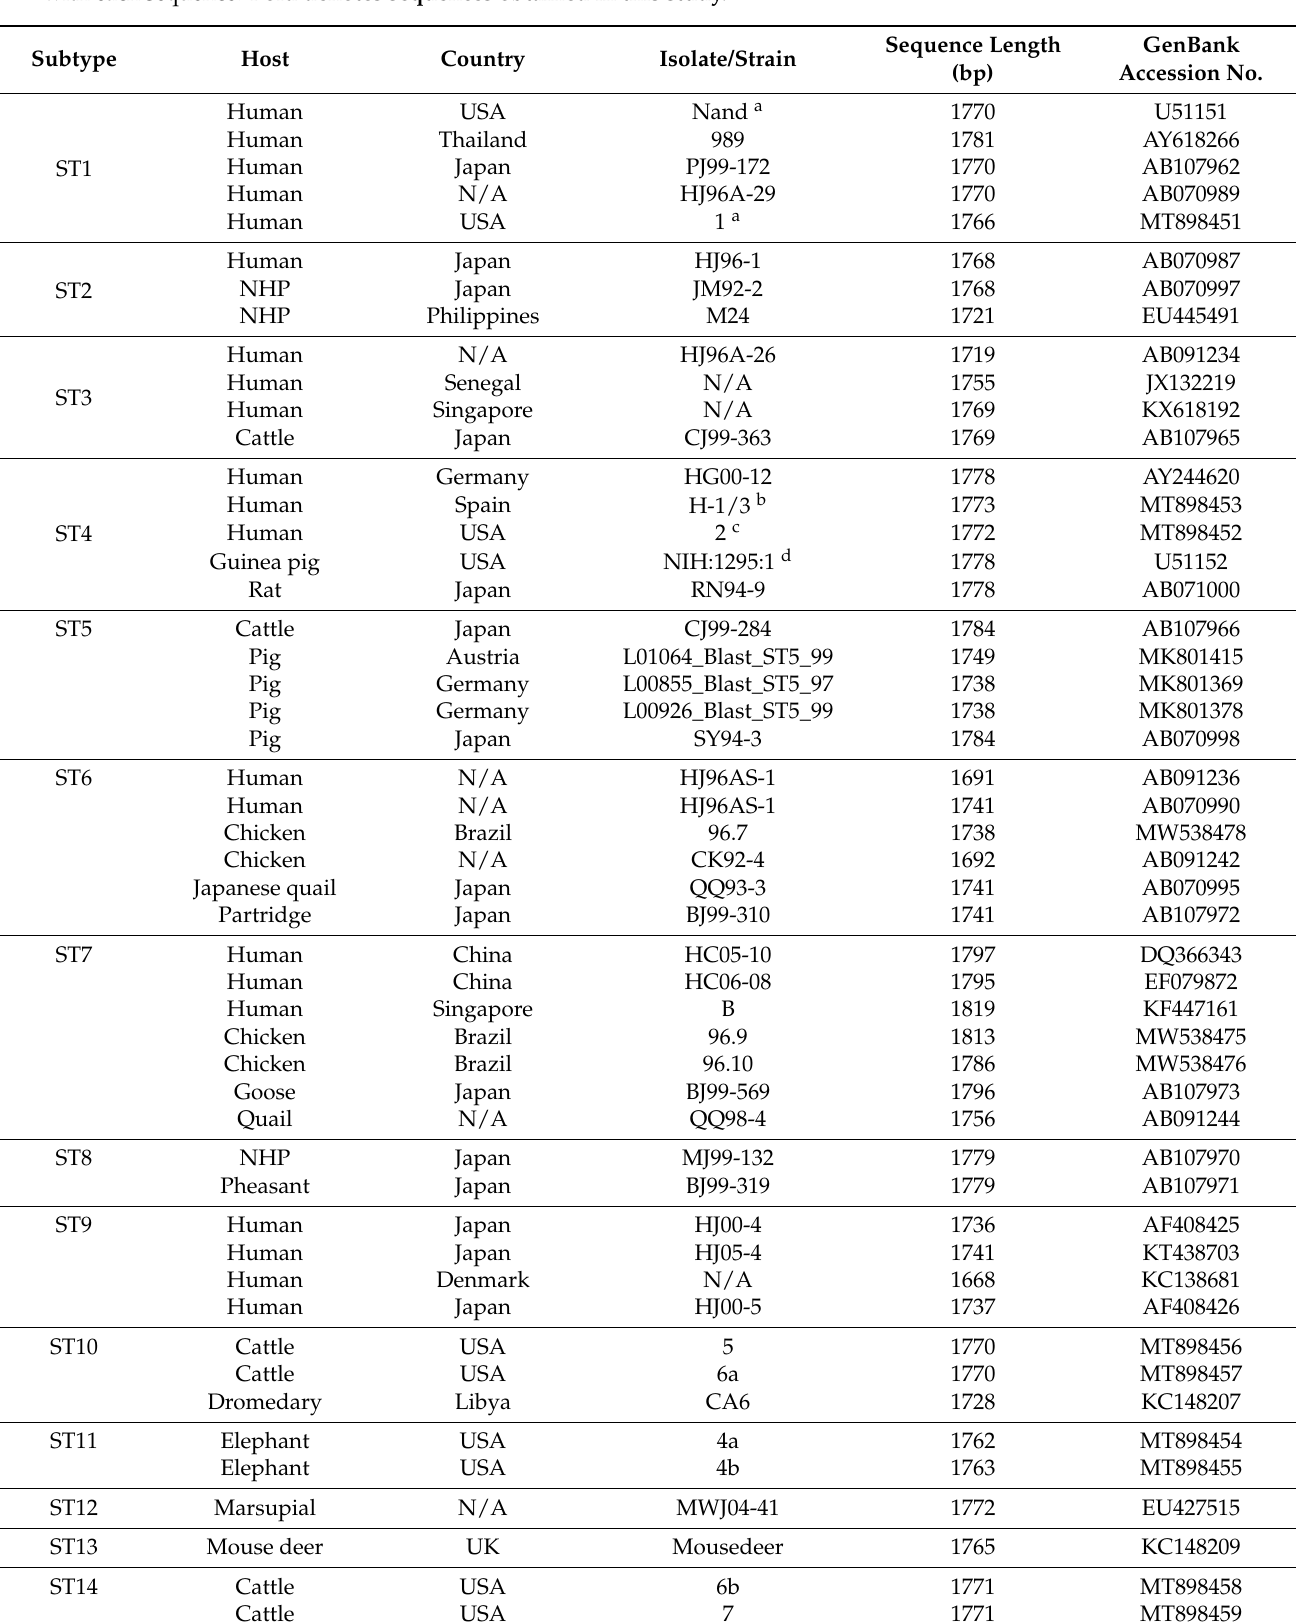
Table 2. Blastocystis full-length SSU rRNA gene nucleotide sequences used in the construction of phylogenetic trees including information on host, country of origin, isolate/strain, sequence length, and GenBank accession number associated with each sequence. Bold denotes sequences obtained in this